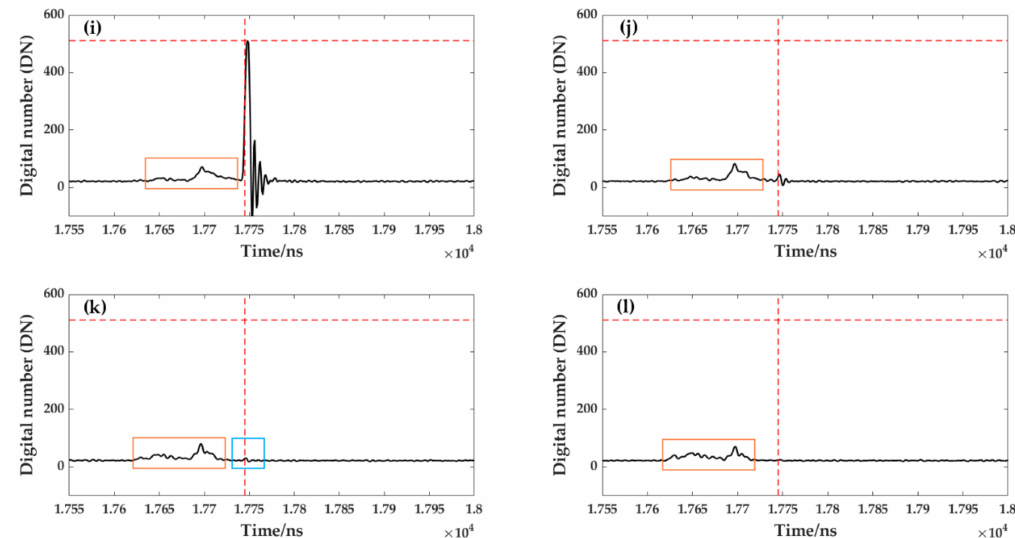
Figure 7. ( a – l ) are echo waveform diagrams corresponding to each spot from A to I in Figure 6, showing the changes in the footprint spot waveform from water to land. The red dotted line is the starting position of the spot saturation phenomenon and denotes the echo peak position of the water surface. The waveform marked by the green rectangle indicates that it is not sure whether there is a land echo or noise. The waveform marked by the blue rectangle indicates that it is not sure whether there is a water echo or noise. The waveform marked by the orange rectangle is the echo waveform from land.